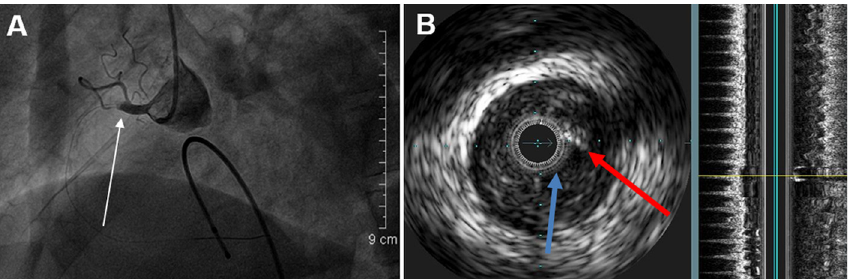
Fig 1. Pre-CAG and IVUS of a reprehensive no-reflow case. A 55-year-old male patient was admitted for "acute inferior myocardial infarction". Emergency CAG revealed the occlusions of the proximal right coronary artery (arrow, Fig 1A). IVUS detected the thrombosis shadow (red arrow) and thin fibrous cap (blue arrow); the longitudinal image served as the localization of the plaque (yellow line) (Fig